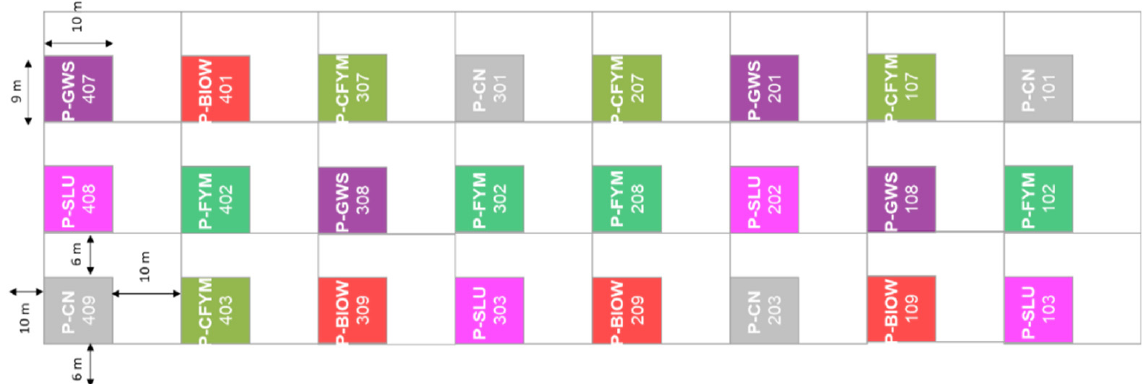
Figure 2. Experimental plan of the PROspective site, with the following OWP treatments applied: sewage sludge (P-SLU), co-compost of sewage sludge and green waste (P-GWS), biowaste compost (P-BIOW), farmyard manure (P-FYM), compost of farmyard manure (P-CFYM) and no organic amendment (P-CN).